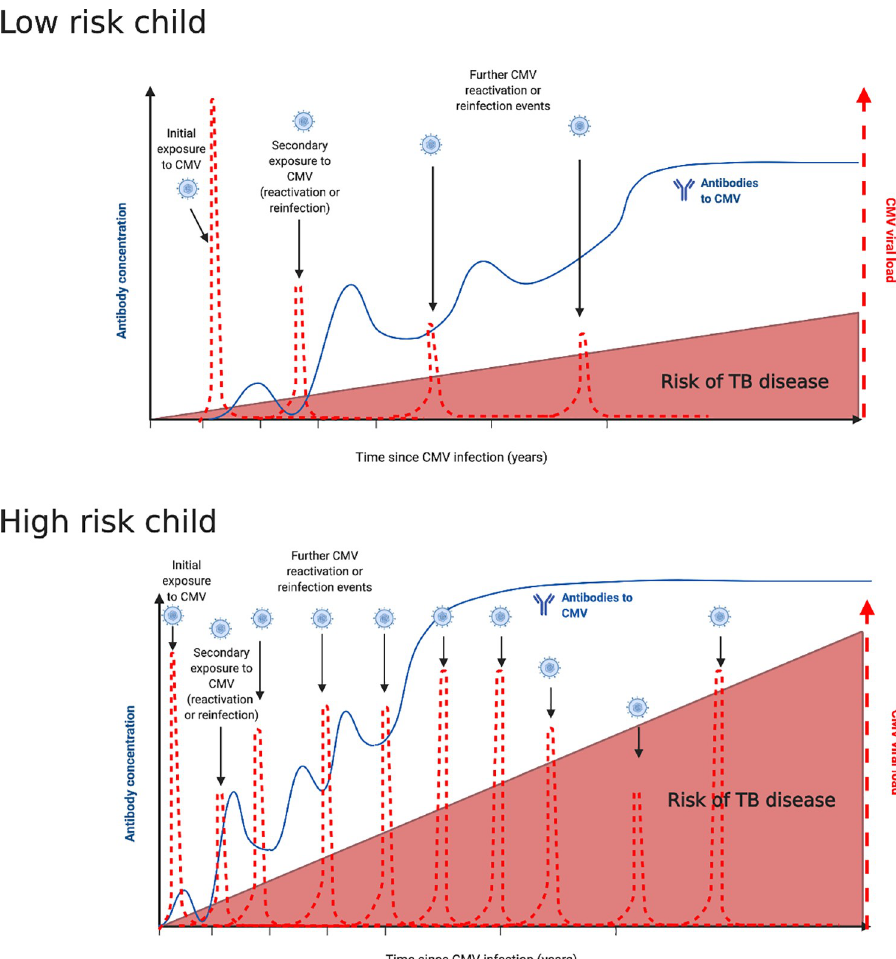
Fig 2. Conceptual framework of TB and CMV interaction in low- and high-risk children. Conceptual framework of TB and CMV interaction in high-and low-risk children. Black arrows represent CMV infection, reactivation, or reinfection events. Red dashed lines show hypothesised CMV viral load following infection, reactivation, or reinfection events. Blue line represents IgG antibody levels to CMV. Lower risk child—immune competent children aged approximately between 4 and 15. Higher risk children—children aged less than 4 years old, immune compromised, HIV infected, older adolescent (over 15 years of age). Created with BioRender.com. CMV, cytomegalovirus; TB,